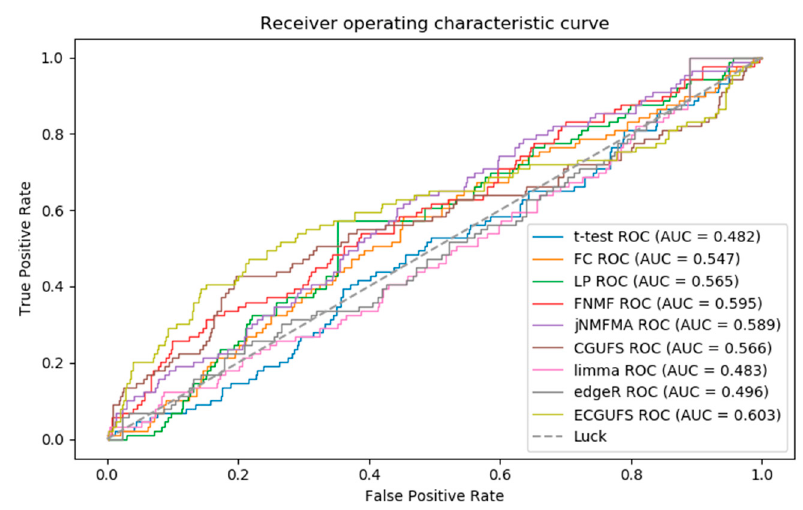
Figure 2. ROC curves of the t -test, fold change (FC), multi-label propagation clustering algorithm (LP), FNMF, jNMFMA, CGUFS, limma, edgeR, and ECGUFS prediction results.